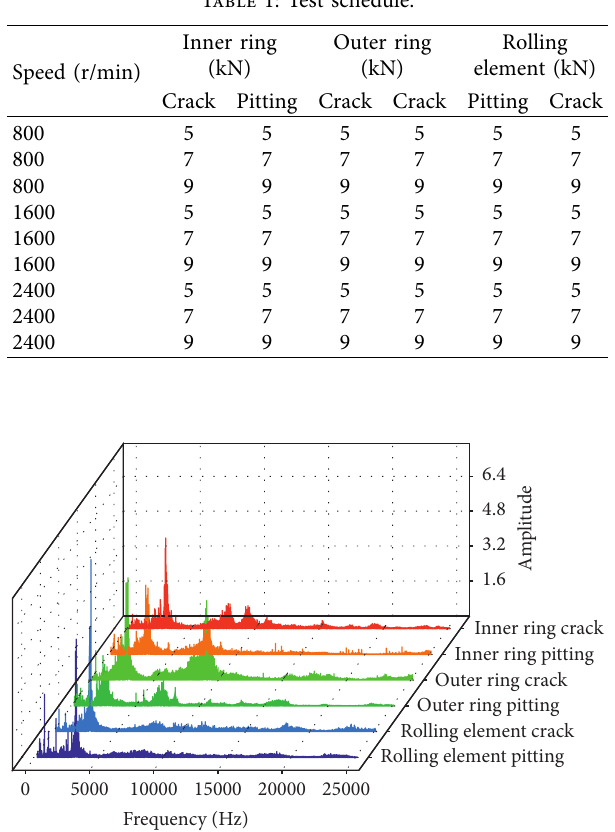
Figure 4: Frequency distribution of bearing vibration signals of six fault types under the same working condition.